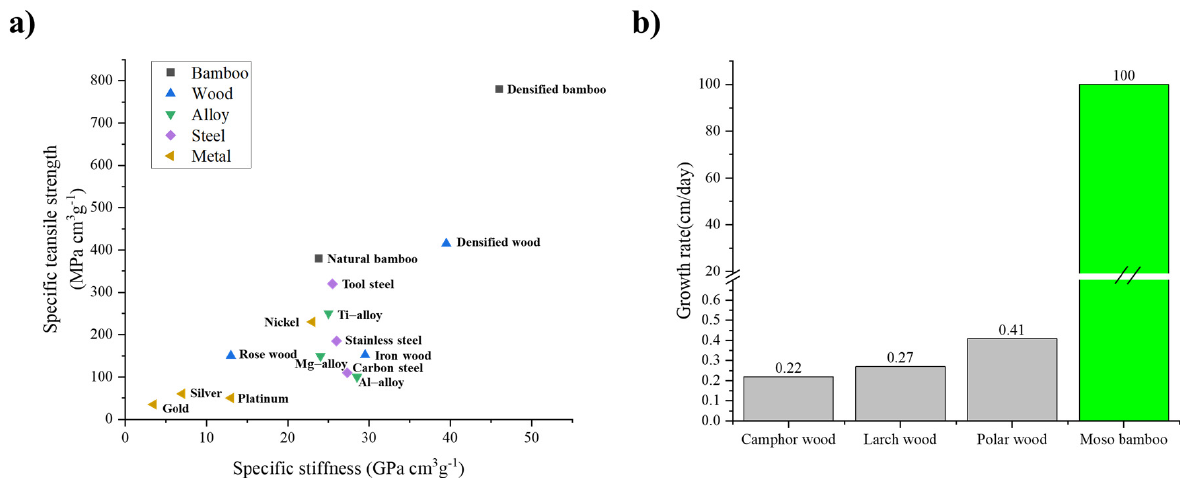
Figure 1. ( a ) Specific tensile strength versus specific stiffness of the densified bamboo compared to other natural materials, engineered steel, and strong metallic alloys [3]; ( b ) growth rates of typical bamboo and various wood species [3].